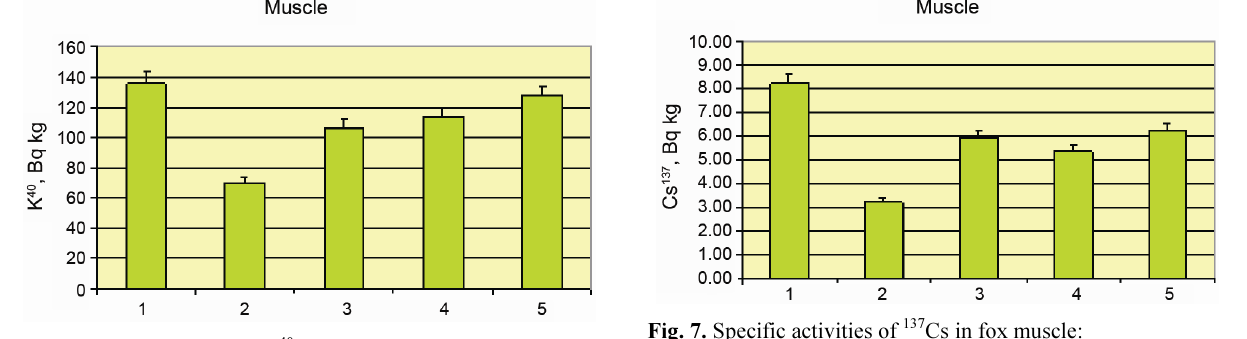
Fig. 4. Specific activities of